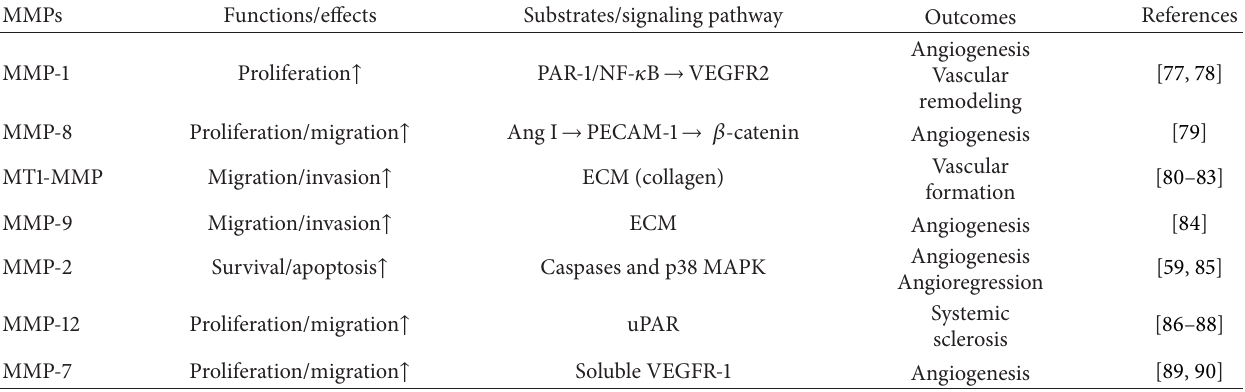
Table 2: MMPs and vascular EC function in